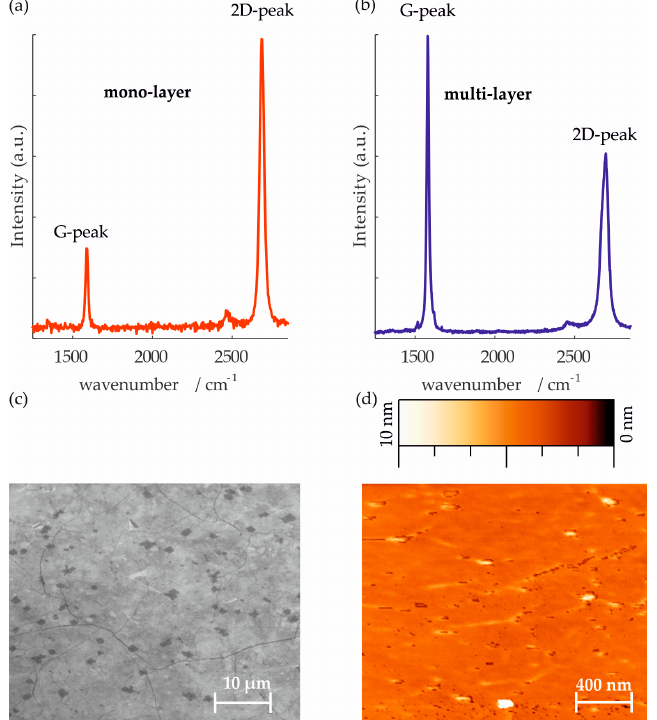
Figure 2. Representative Raman spectra with an excitation wavelength of 532 nm measured on CVD grown graphene: ( a ) mono-layer graphene with 2D/G intensity ratio of 3.45; ( b ) multi-layer graphene (6 to 8 layers) with 2D/G intensity ratio of 0.6 purchased from ACS Materials; ( c ) SEM image displaying structure of our mono-layer graphene on a Si-SiO 2 wafer; ( d ) High-resolution AFM measurement displaying roughness of a mono-layer graphene on a Si-SiO 2 wafer.